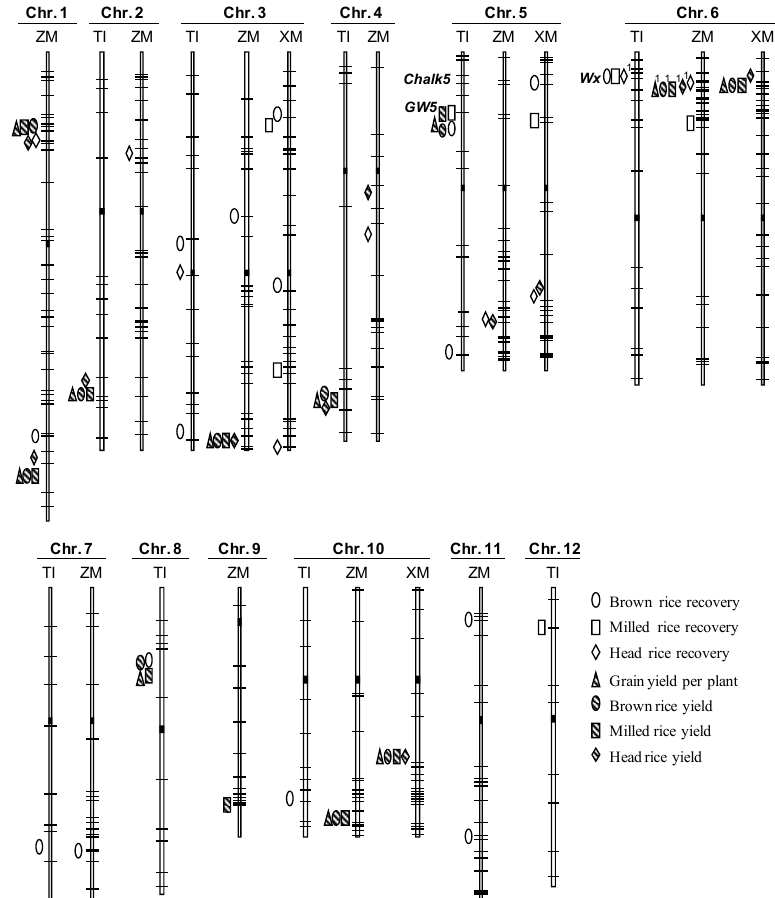
Figure 1. Genomic distribution of QTLs for seven traits detected in three RIL populations. TI = Teqing / IRBB lines; ZM = Zhenshan 97 / Milyang 46; XM = Xieqingzao / Milyang 46. Marker positions in each chromosome are indicated by solid lines and the distances are in proportion to the physical length. Solid rectangles refer to the approximate positions of centromeres. QTLs are drawn on the left side of the corresponding interval. Significant genotype-by-environment interaction is indicated by the number “1”.